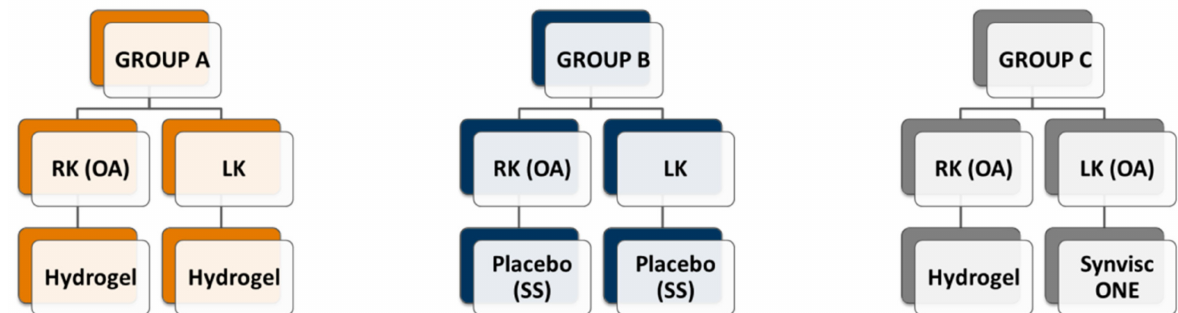
Figure 1. Test in vivo (rabbit model). RK: right knee; LK: left knee; OA: osteoarthritis generated by anterior cruciate ligament transection; SS: saline